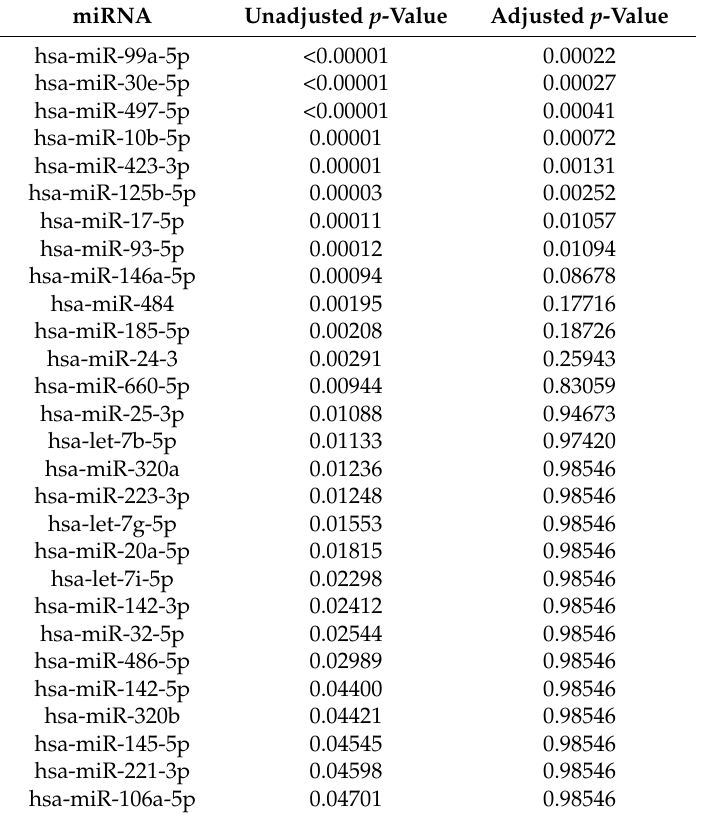
Table 2. Effect of disease duration on miRNA expression